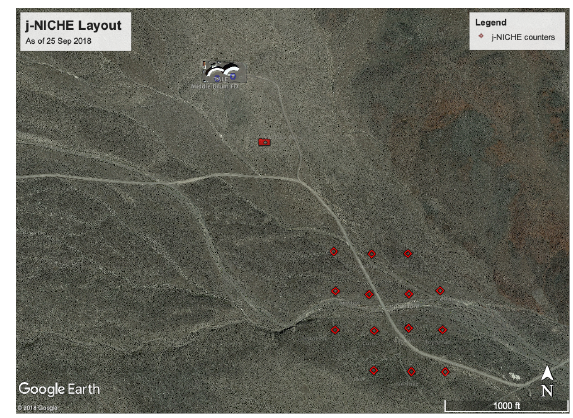
Figure 2. The location of the 14 NICHE counters with respect to the TALE fluorescence site.